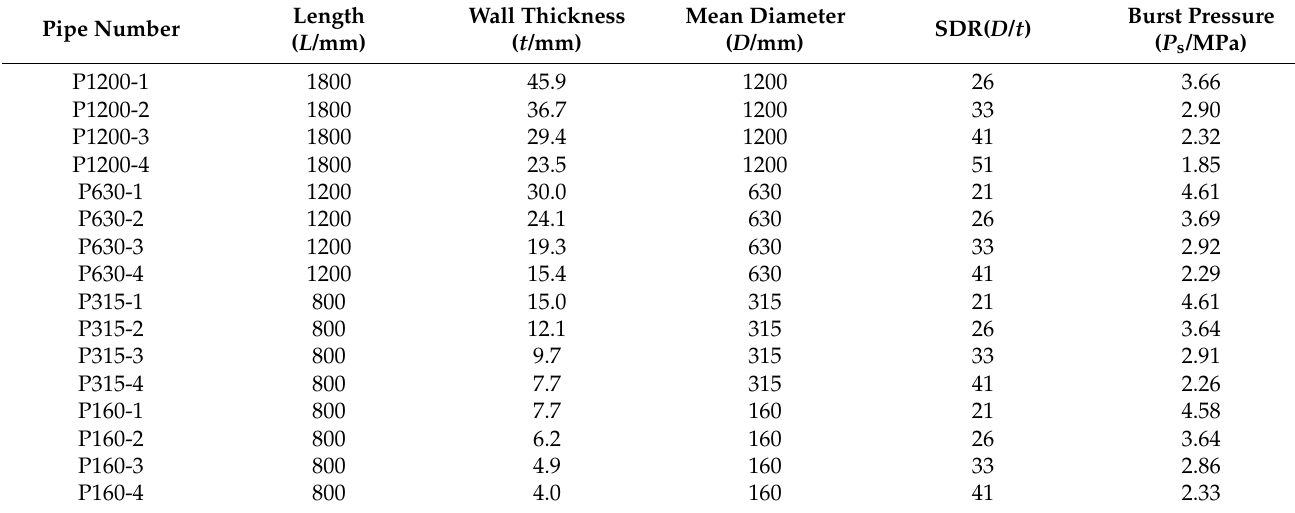
Figure 8. Schematic diagram of PVC pipe samples. Table 2. Pipe specimen geometry and test results.